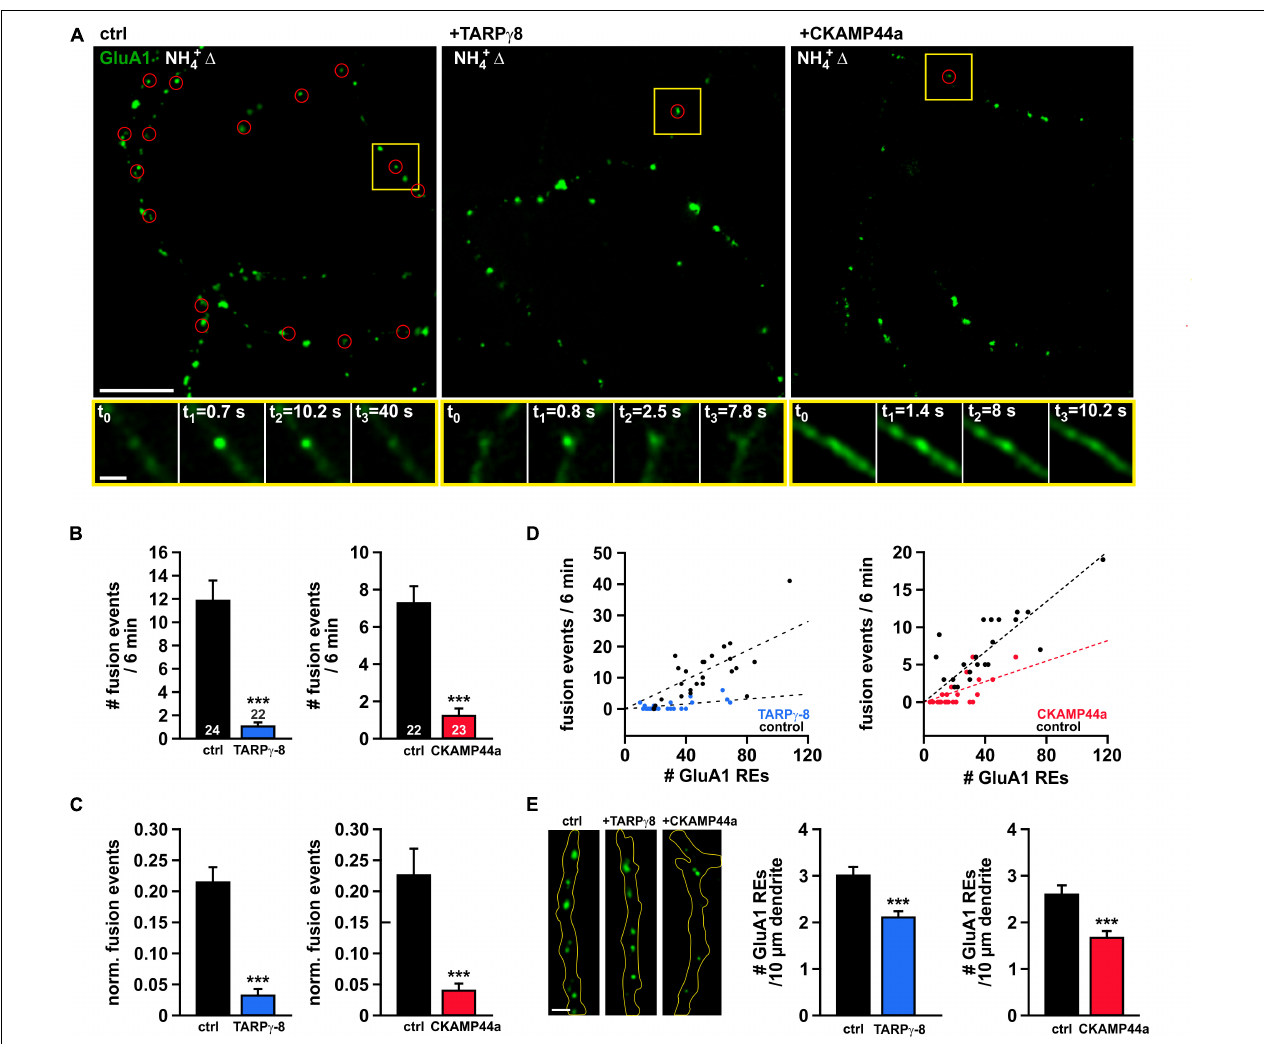
FIGURE 2 | High abundance of TARP γ -8 or CKAMP44a diminishes spontaneous fusion events in dendrites. (A) Exemplary overlay images (scale bar = 10 µ m) showing “visualized” intracellular SEP-GluA1-positive organelles (green) and corresponding sites of fusion events (red circles) that were identified during recording intervals of 6 min in controls (left) , neurons overexpressing TARP γ -8 (middle) , or neurons overexpressing CKAMP44a (right) . Yellow rectangles mark the position of exemplary fusion events that are shown in time series below each overview picture (acquisition frequency: 10 Hz). Scale bar of enlarged time series images is 2 µ m. (B) Quantification of the average number of delivery events observed in 6 mins for dendritic structures from neurons overexpressing TARP γ -8 or CKAMP44a in comparison to controls. (C) Event frequencies were normalized to the number of identified intracellular AMPAR-containing organelles (recycling endosomes) in the field of view. (D) Plots of event frequency versus number of recycling endosomes for neurons overexpressing TARP γ -8, CKAMP44a, and corresponding controls. Note the altered relationship (slope of fit line) in neurons with increased auxiliary subunit levels. (E) Quantification of the density of AMPAR-containing intracellular compartments in dendritic segments. Exemplary images of dendrite segments of control neurons and neurons overexpressing TARP γ -8 or CKAMP44a are shown (left panel) (scale bar = 2 µ m). The mean density of dendritic SEP-GluA1-positive intracellular structures in neurons overexpressing either auxiliary subunit was quantified (right panel) . Data are mean ± SEM. n -values are given in panel (B) and apply to all data shown. Student’s t -test was used for statistical analysis. ***p <